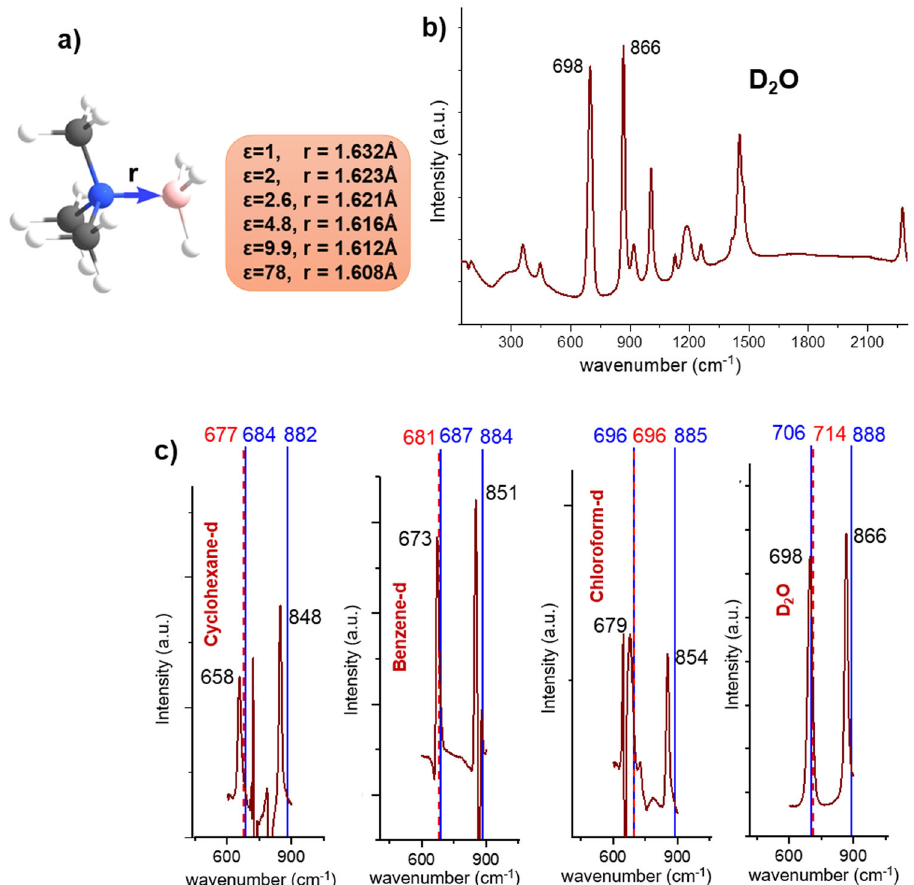
Fig. 1 The calculated and observed structural and spectroscopic data of Me 3 NBH 3 . a The optimized geometry of Me 3 NBH 3 . The B – N distances ( r ) are given in the gas phase ( ε = 1) and various solvents, cyclohexane ( ε = 2.0), carbon disul fi de ( ε = 2.6), chloroform ( ε = 4.8), o -dichlorobenzene ( ε = 9.9), and water ( ε = 78.0); b the Raman spectra of Me 3 NBH 3 measured in D 2 O; c the relevant part of the Raman spectra ranging 450 – 1050 cm − 1 in various solvents. The PBE0-D3/def2-QZVP calculated harmonic (in blue color) and anharmonic (in red color) frequencies are shown (C: gray, N: blue, H: white, B: